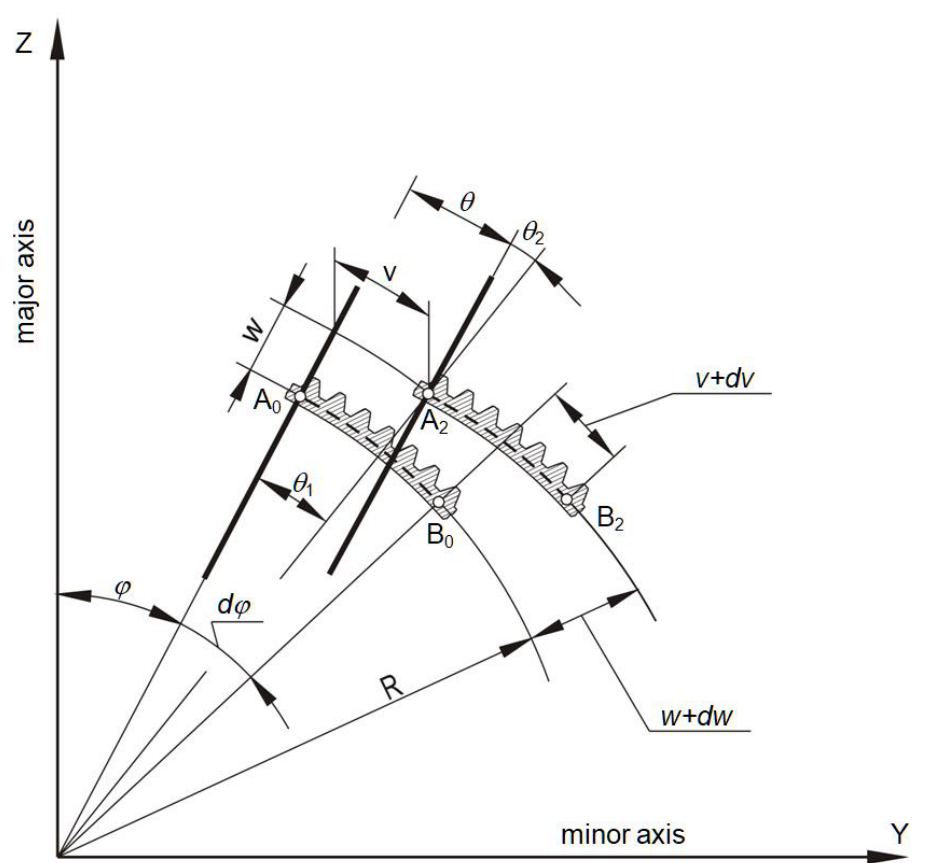
Figure 4. The angle of rotation of the normal exposed, in point A 0 , to the neutral layer of flexspline deformed by the generator.